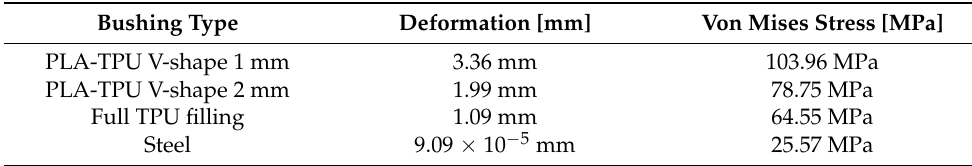
Table 5. Deformation and von Mises stress of each bushing at 200 N force.